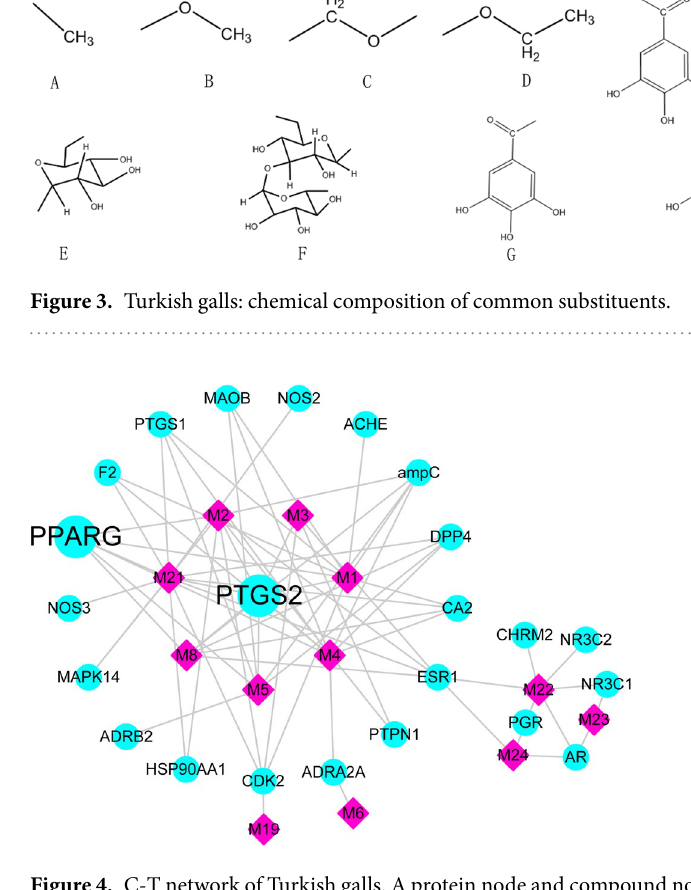
Figure 4. C-T network of Turkish galls. A protein node and compound node are linked if the protein is targeted by the corresponding compound. The node size is proportional to its degree. The dark pink diamonds represent the Turkish galls compounds. The light green circles represent the Turkish galls targets.